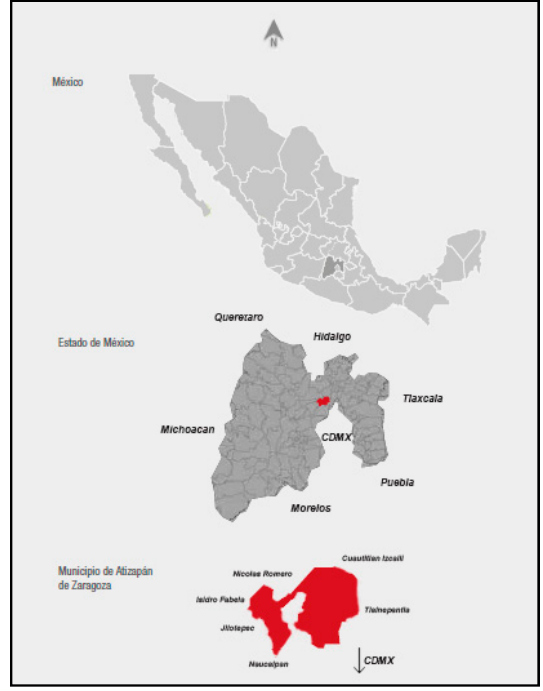
Figure 1. Location of the municipality Atizapán de Zaragoza in Mexico (by authors, data INEGI).